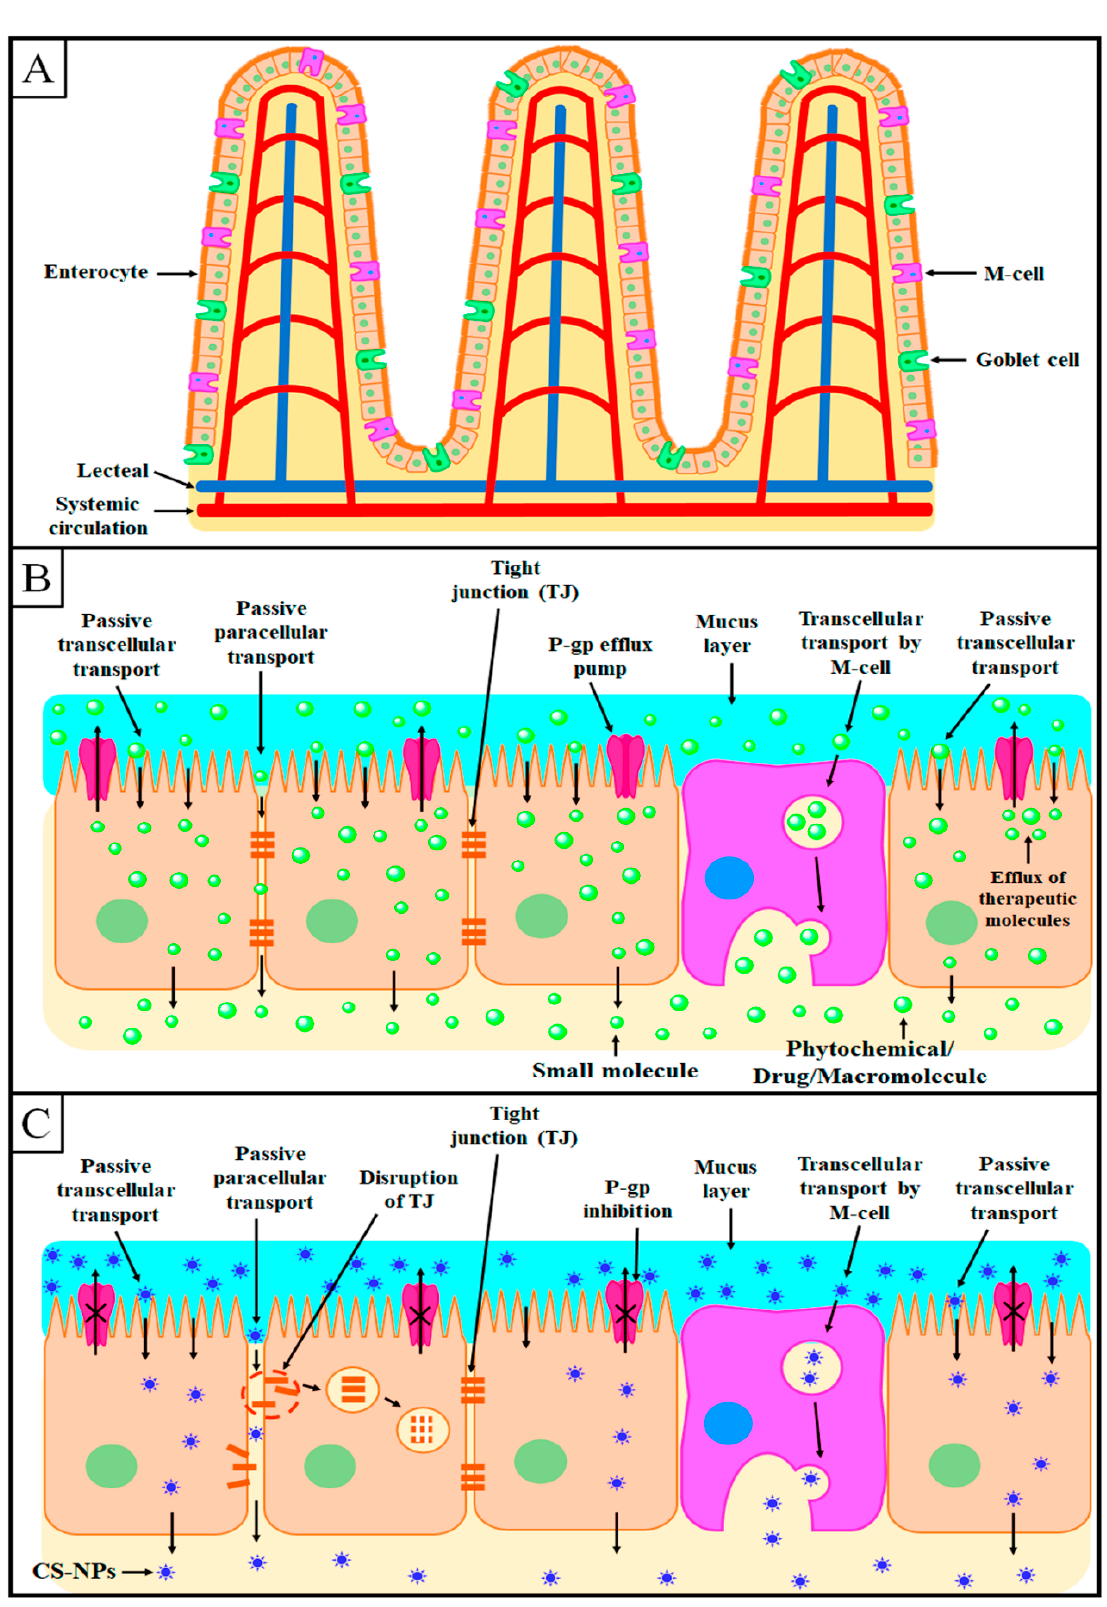
Figure 5. Schematic illustrations of ( A ) the structure of the intestinal epithelium, ( B ) different transport mechanisms of pure phytochemicals/synthetic drugs/macromolecules, and ( C ) different transport mechanisms of phytochemical-loaded CS-NPs.